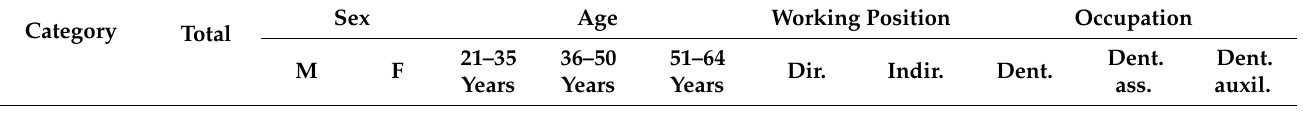
Table 2. Prevalence of psychological distress and PTSD symptoms in healthcare